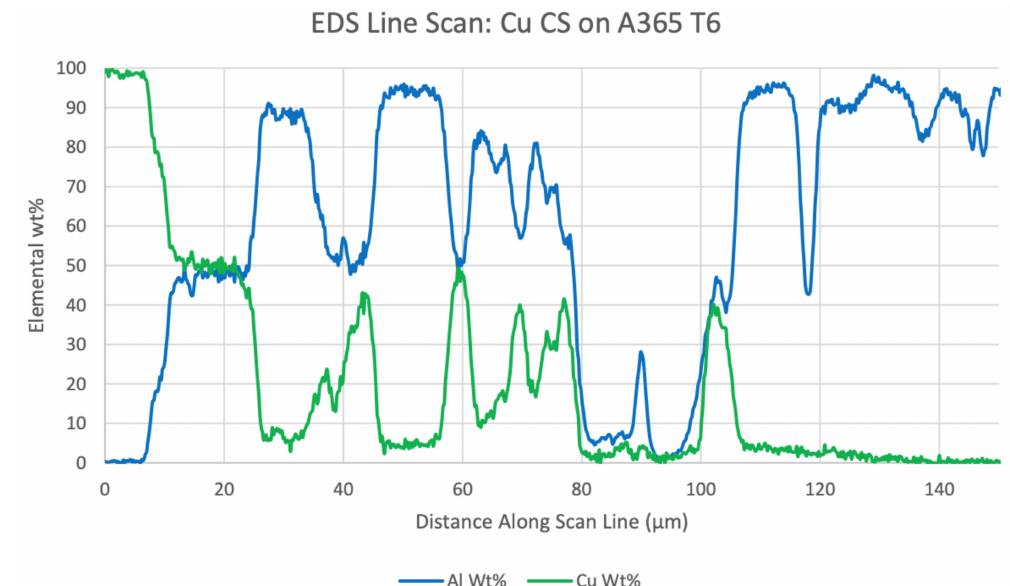
Figure 6. Presentation of the EDS line scan recorded for the Cu CGDS coated HPDC A365 substrate system in the thermally postprocessed condition.